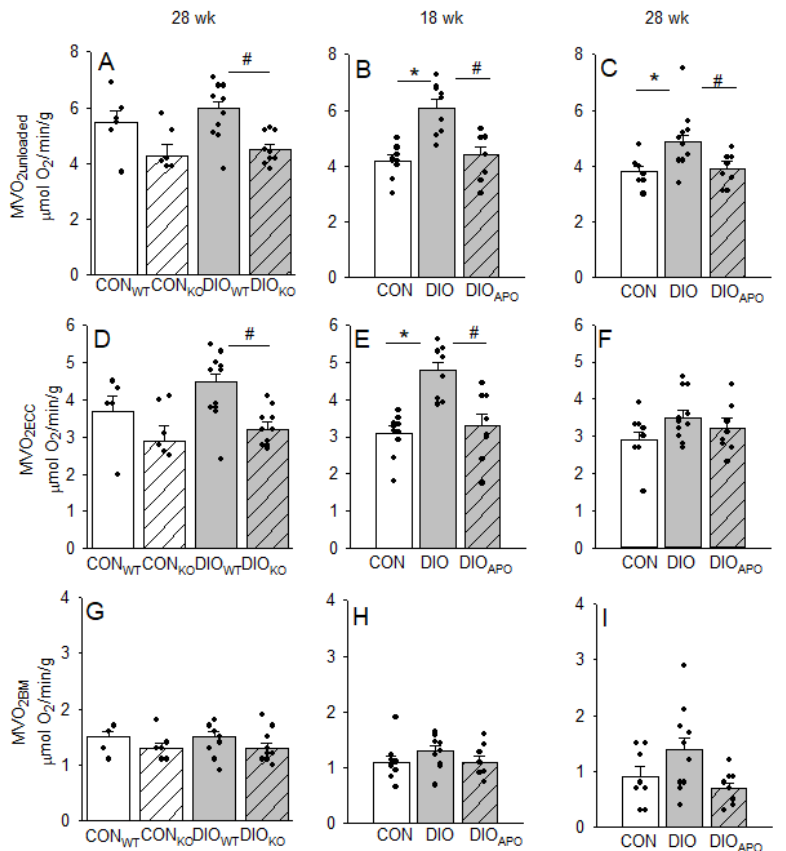
Figure 4. Myocardial oxygen consumption in mechanically unloaded hearts (MVO 2unloaded , A – C ) and for processes associated with excitation-contraction coupling (MVO 2ECC , D–F) and basal metabolism (MVO 2BM , G – I ) that was obtained from lean controls wild-type (CON WT ) and NOX2-KO mice (CON KO ) and obese mice fed a high fat diet for 28 weeks (DIO WT and DIO KO ). ( A , D , and G ). Also shown in lean controls (CON) and untreated and apocynin-treated obese C57BL/6J mice (DIO and DIO APO ) that were fed a western diet for 18 weeks ( B , E , and H ) or 28 weeks ( C , F , and I ). Single values and means ± SEM. * p < 0.05 within the same genotype, # p < 0.05 between genotypes within the same diet.